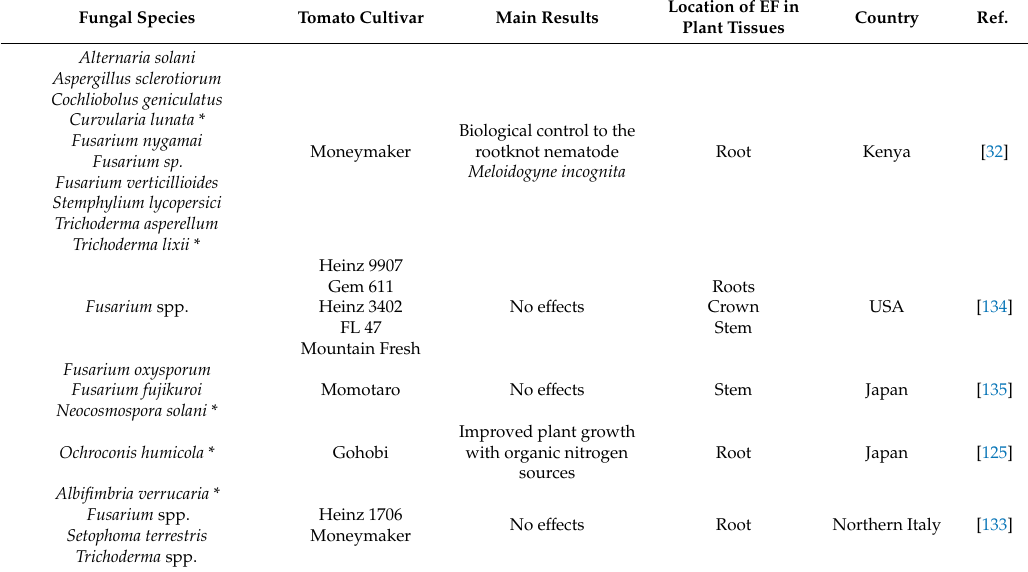
Table 3. Naturally occurring constitutive endophytes of tomato.